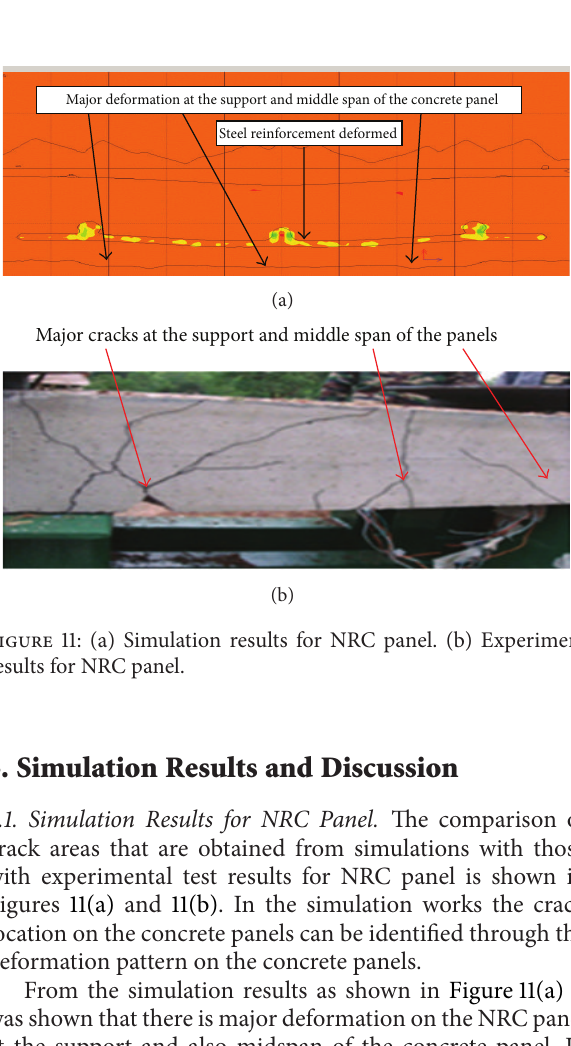
Figure 10: 2D model for simulation works.